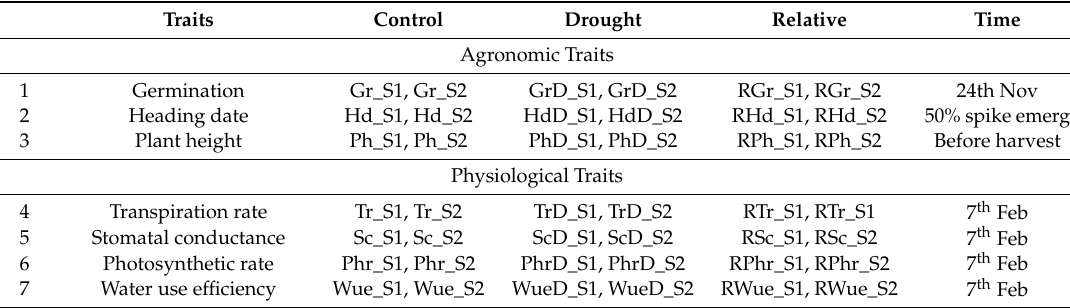
Table 4. Absolute and relative traits measured for RIL population in 2016–17 (trait abbreviation followed by _S1) and 2017–18 (trait abbreviation followed by _S2) in control and drought and their time of measurement each